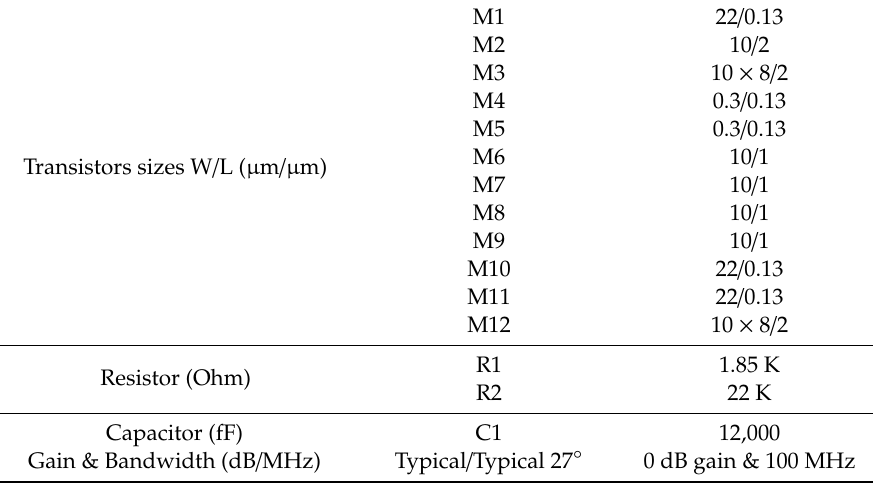
Figure 8. Level shifter. Table 5. Component sizes and simulated performance specifications.